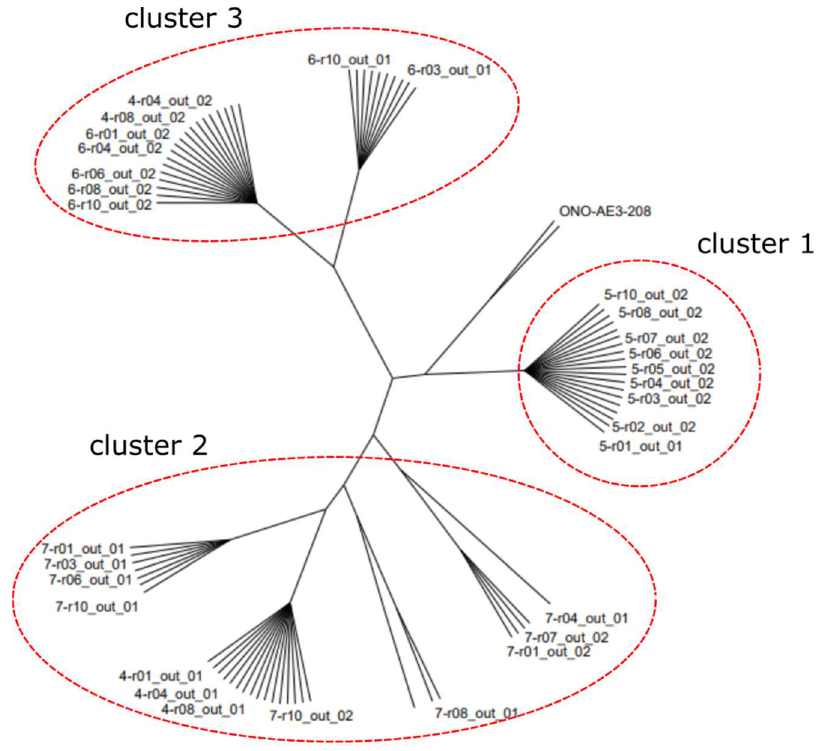
Figure 5. Map tree obtained from AuPosSOM. Each cluster represents a different ligand footprint on the EP4 ligand complex. The co-crystalized inhibitor of EP4 is shown as ligand.